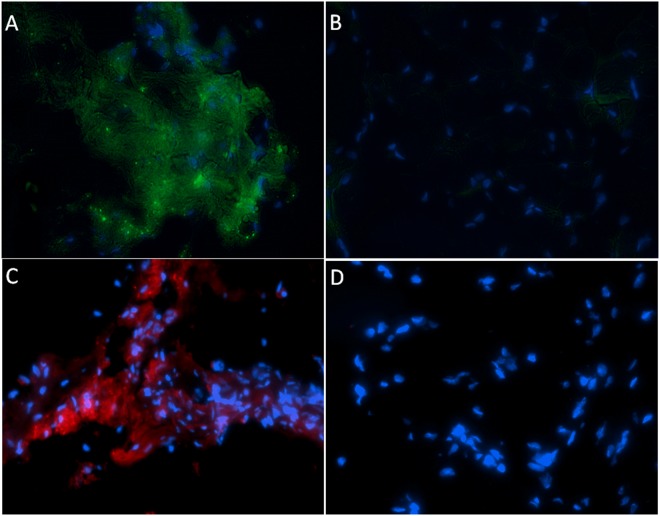
Immunofluorescence staining of rat tissue with MUC5AC and villin.Panel A and B show MUC5AC immunofluorescence staining for primary adenocarcinoma in Levrat esophagus and normal esophagus, respectively. Panel C and D show villin immunofluorescence staining in Levrat esophagus and normal esophagus, respectively. Positive MUC5AC and villin staining were detected in primary tumor with the Alexa Fluor 488 secondary antibody, conjugated to a green fluorophore and the Alexa 594 secondary antibody, conjugated to a red fluorophore, respectively. Normal esophagus shows the absence of MUC5AC and villin staining.